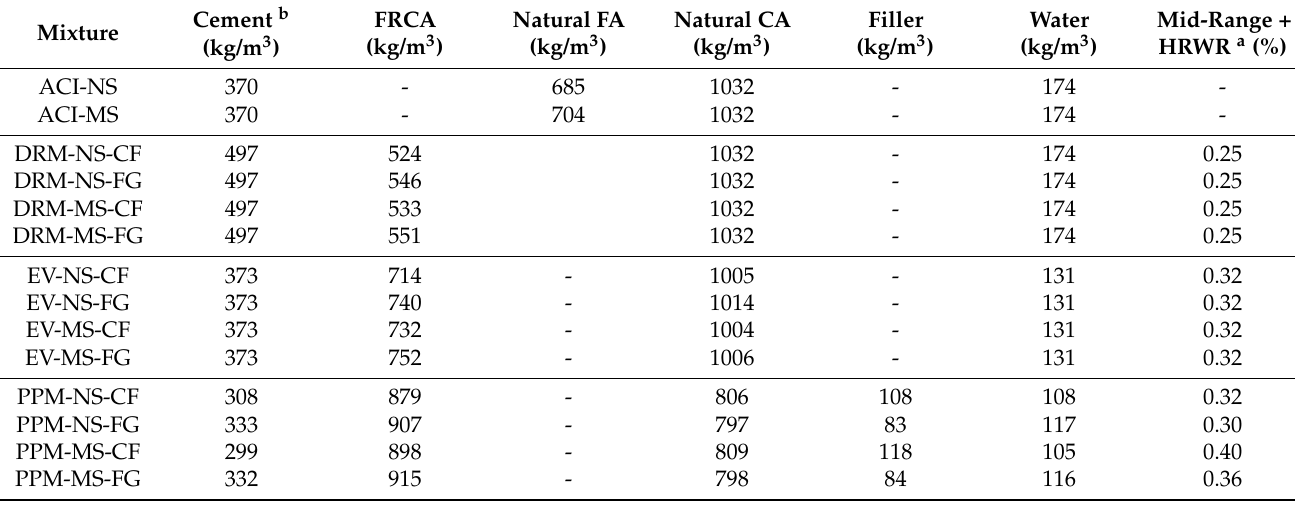
Table 4. FRCA and control concrete mix design